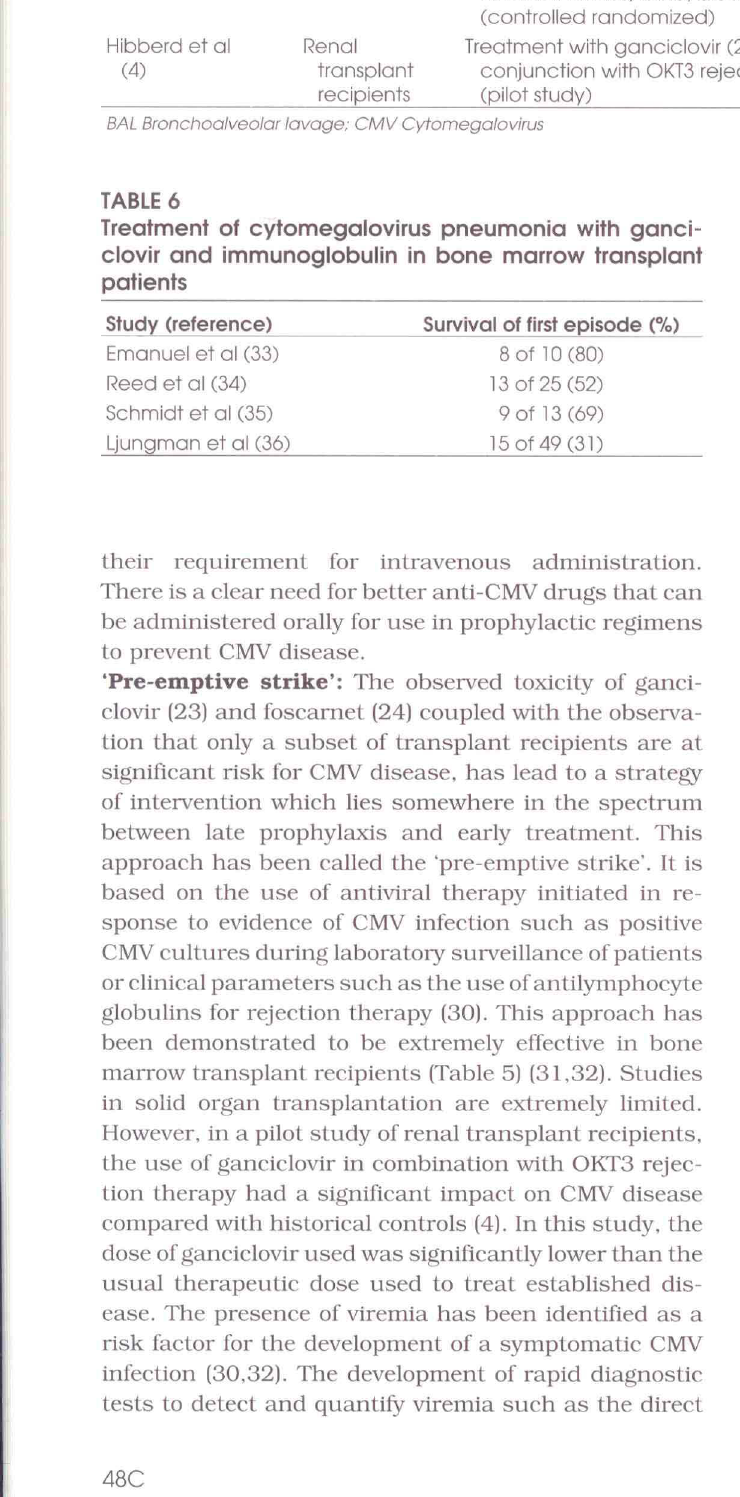
Treatment of cytomegalovirus pneumonia with ganci clovir and immunoglobulin in bone marrow transplant